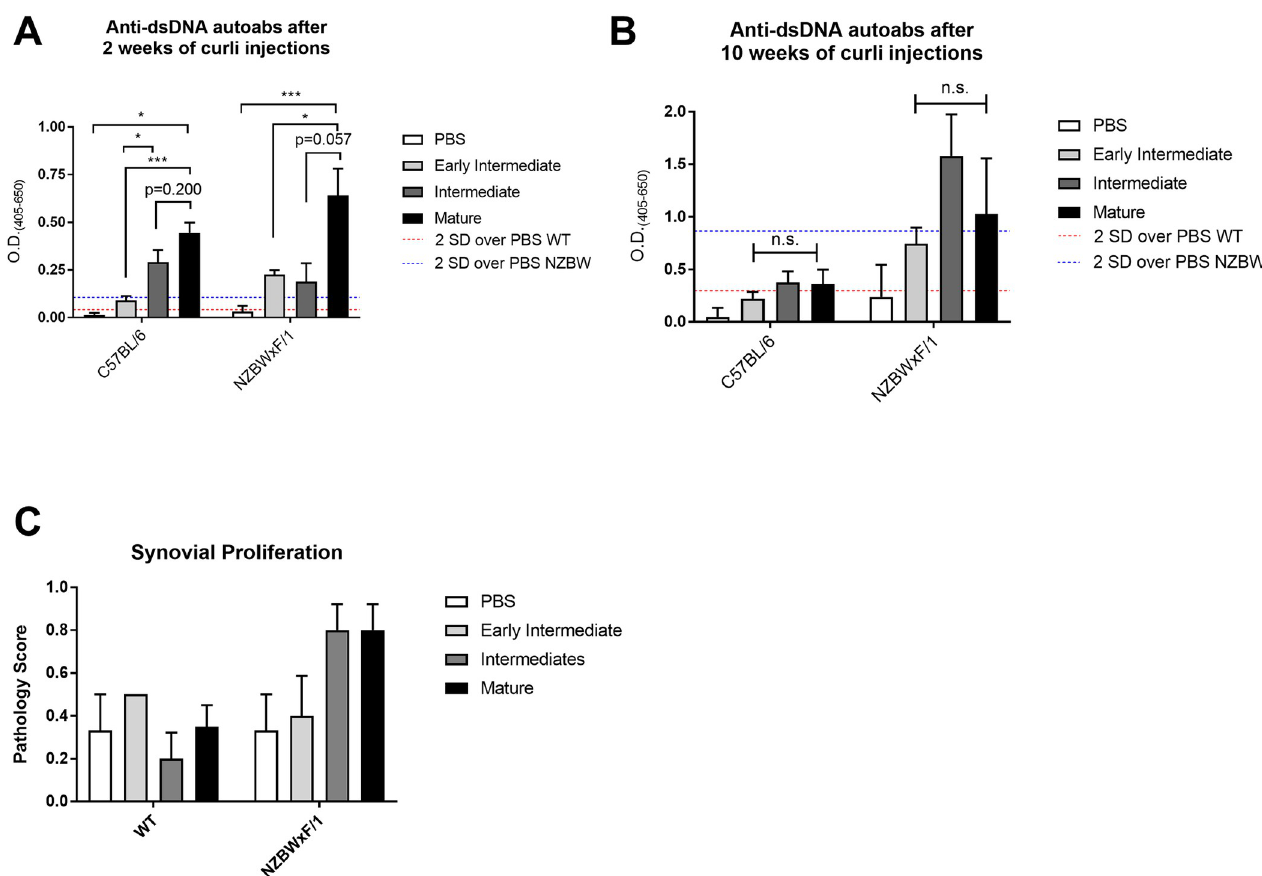
Fig 6. Structure and DNA content of curli complexes dictates the autoimmune response in mice. (A and B) Levels of anti-dsDNA autoantibodies in the sera of C57BL/6 and NZBWxF/1 mice treated with curli preparations twice weekly for A) 2 weeks and B) 10 weeks. For mice treated with curli preparations, n = 5; for PBS controls, n = 3. One representative experiment of three independent experiments is shown. (C) Joint pathology scores for C57BL/6 and NZBWxF/1 mice injected with 50 μ g of early intermediate, intermediate, or mature curli preparations or PBS as a control twice weekly for 12 weeks. Scoring was based on histological parameters: 0, no changes; 1, slight thickening of synovial cell layer ( < 3 layers of synoviocytes) accompanied by congestion and edema of the external membrane; 2, moderate thickening of synovial cell layer (3–5 layers of synoviocytes) accompanied by congestion and edema of the external membrane. Significance was determined by one-way ANOVA with Tukey post-hoc secondary test. � , P < 0.05; ��� , P < 0.001; n.s. not significant.